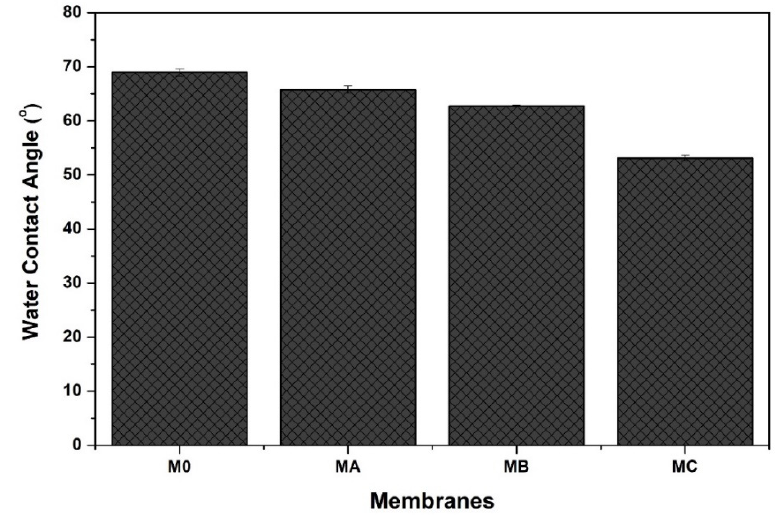
Figure 6. Water contact angle of pure PES and blended PES membrane with polydopamine of different concentrations.